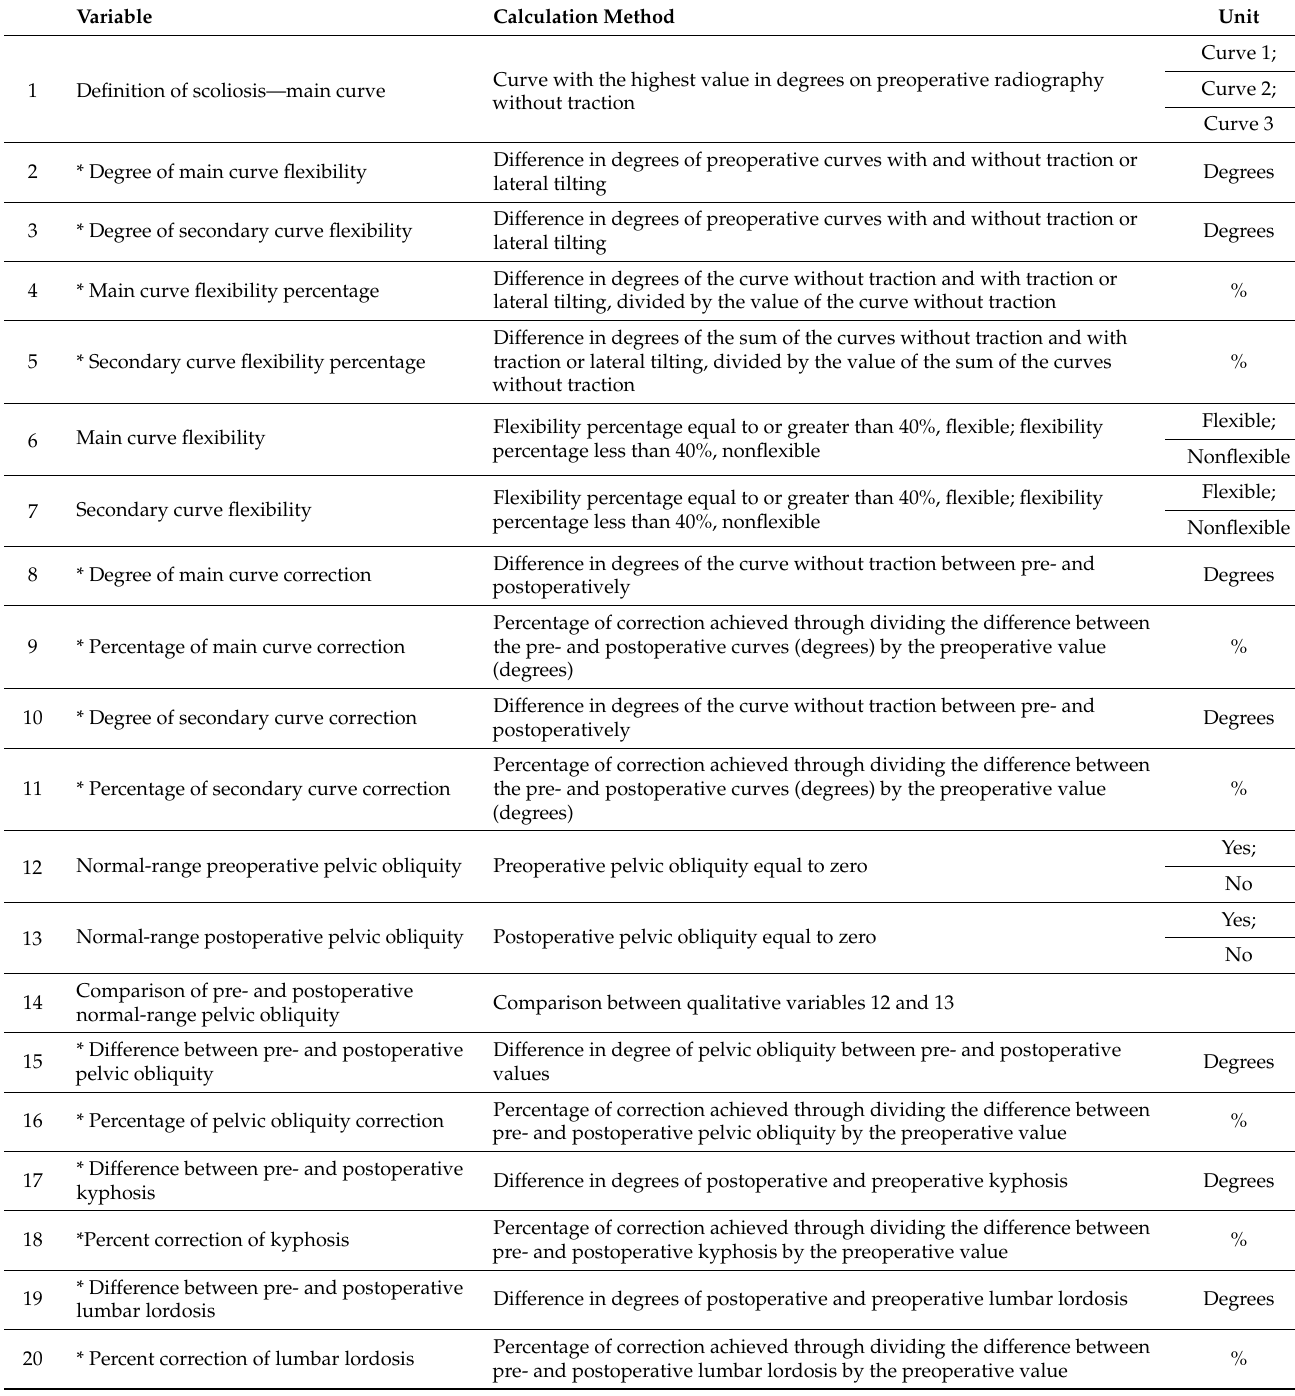
Table A1. Definition of all variables, calculation method and